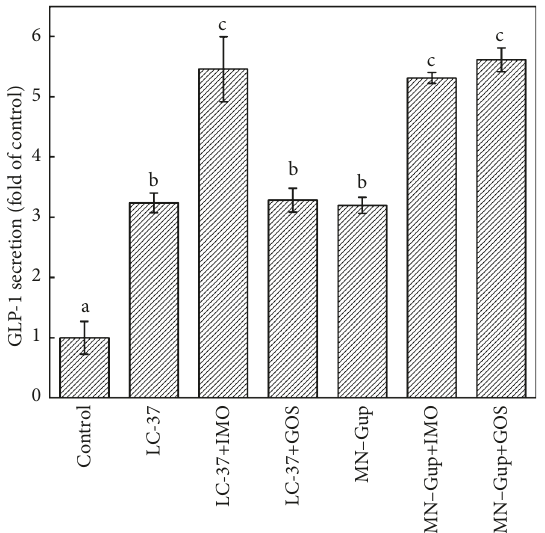
Figure 4: Effects of LC-37 and MN-Gup with prebiotics on in- testinal GLP-1 secretion in NCI-H716 cells. The added contents of IMO and GOS were 1.5%. Control group is incubated with PBS. Data are shown as means ± standard deviations (SD), and different lowercase letters indicate significant differences, p < 0 . 05 ( n �